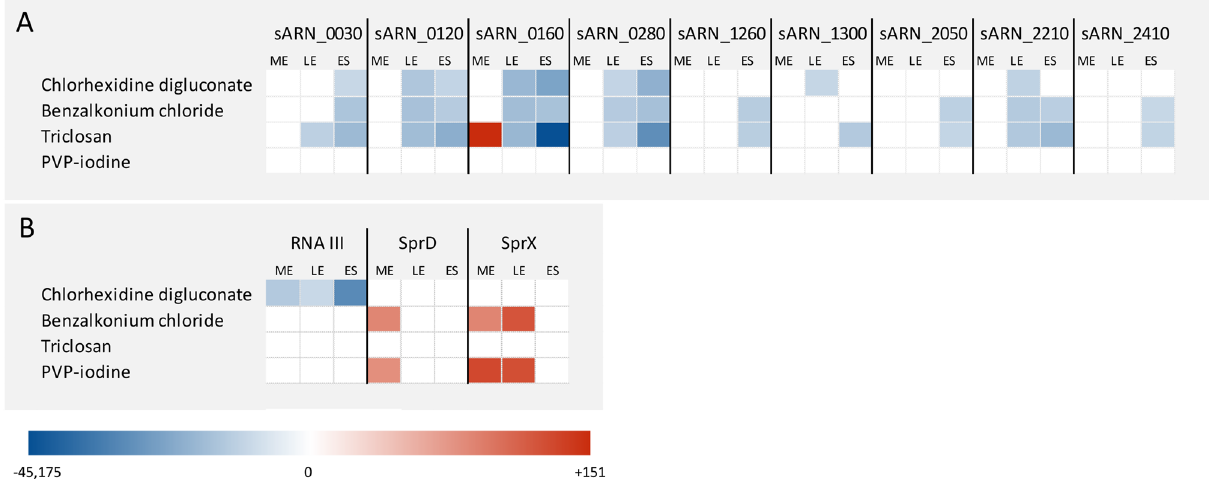
Figure 2. Heat maps illustrating variations in sRNA expression of E. faecium Aus0004 ( A ) and S. aureus HG003 ( B ) at mid exponential, late exponential and early stationary growth phases after exposure to SICs of chlorhexidine digluconate, benzalkonium chloride, PVP-iodine and triclosan. RNA counts were normalized against house-keeping genes ( tmRNA for S. aureus and adk for E. faecium ) using the comparative cycle threshold ΔΔCt method and are expressed in Log 2 fold change. Non-significant shifts in sRNA expression appear in white, significant induction ( P < 0.05) appears in red, significant repression ( P < 0.05) are in